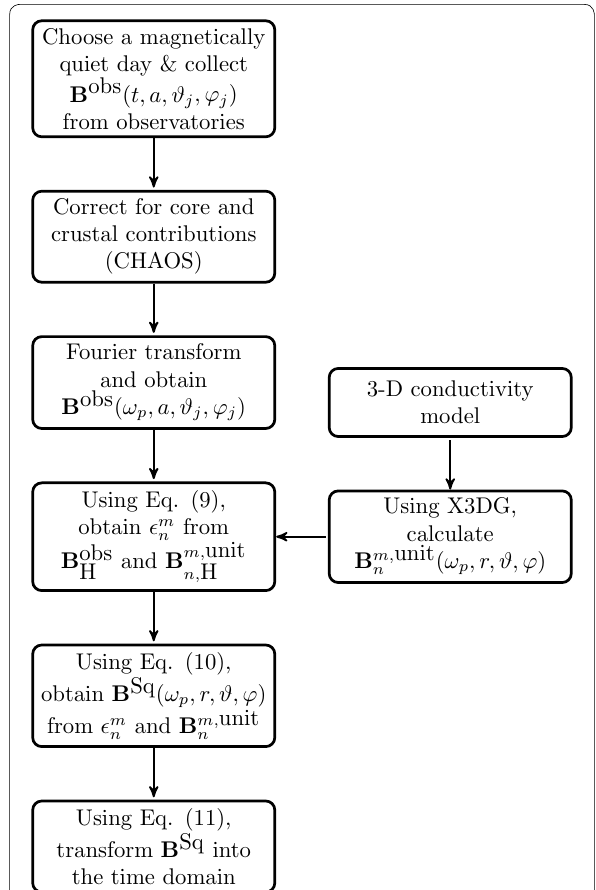
Fig. 3 Work-flow chart used to model Sq variations. At an output, one acquires synthesized Sq magnetic fields at a desired location and time. B H = ( B X , B Y ) stands for the horizontal magnetic field